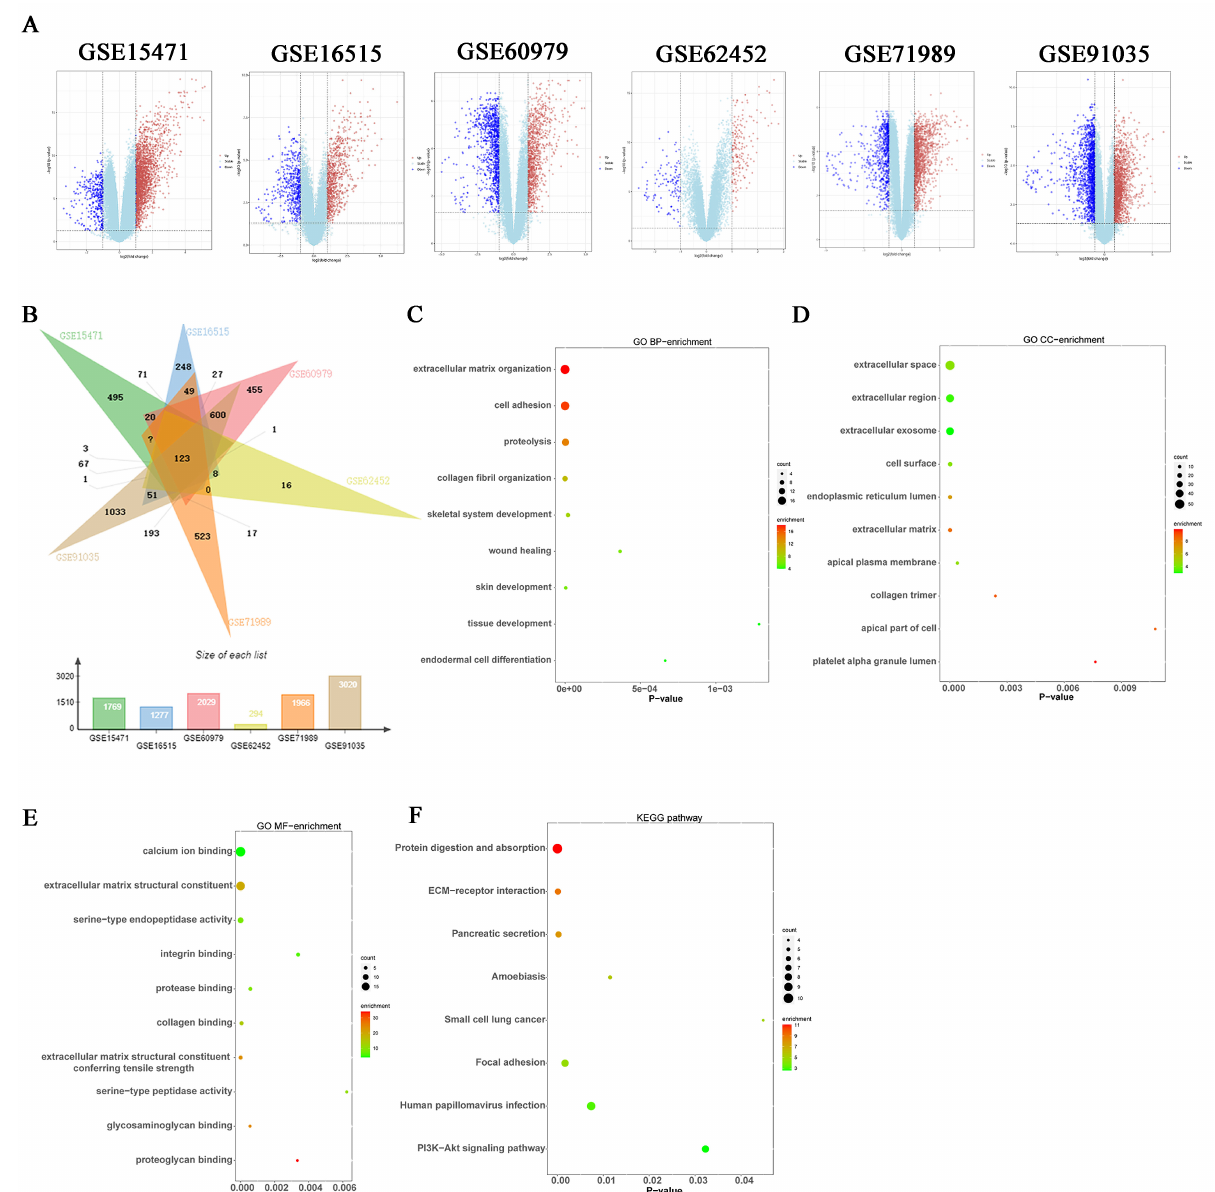
Figure 1. DEGs and their functions in GSE15471, GSE16515, GSE60979, GSE62452, GSE71989, and GSE91035. ( A ) Volcano plot of DEGs between pancreatic cancer tissues and normal pancreas tissues in the GSE15471, GSE16515, GSE60979, GSE62452, GSE71989, and GSE91035 datasets. ( B ) Venn diagram of overlapping 123 DEGs from the GSE15471, GSE16515, GSE60979, GSE62452, GSE71989, and GSE91035 datasets; ( C ) GO (Biological process) analysis of the overlapping DEGs in pancreatic cancer. ( D ) GO (Cellular component) analysis of the overlapping DEGs in pancreatic cancer. ( E ) GO (Molecular function) analysis of the overlapping DEGs in pancreatic cancer. ( F ) KEGG pathway analysis of the overlapping DEGs in pancreatic